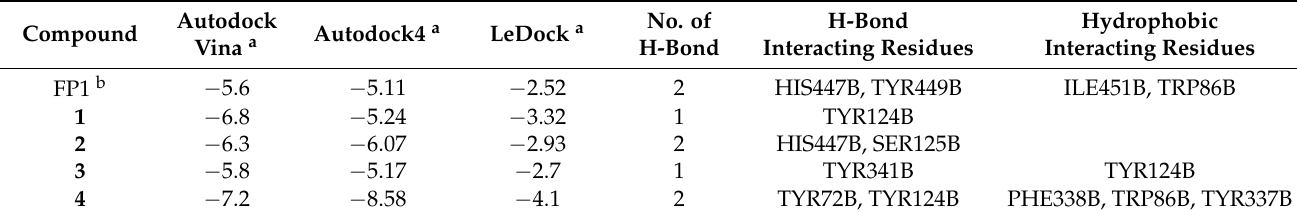
Table 2. In silico docking scores of the control and the compounds 1 – 4 against AChE.